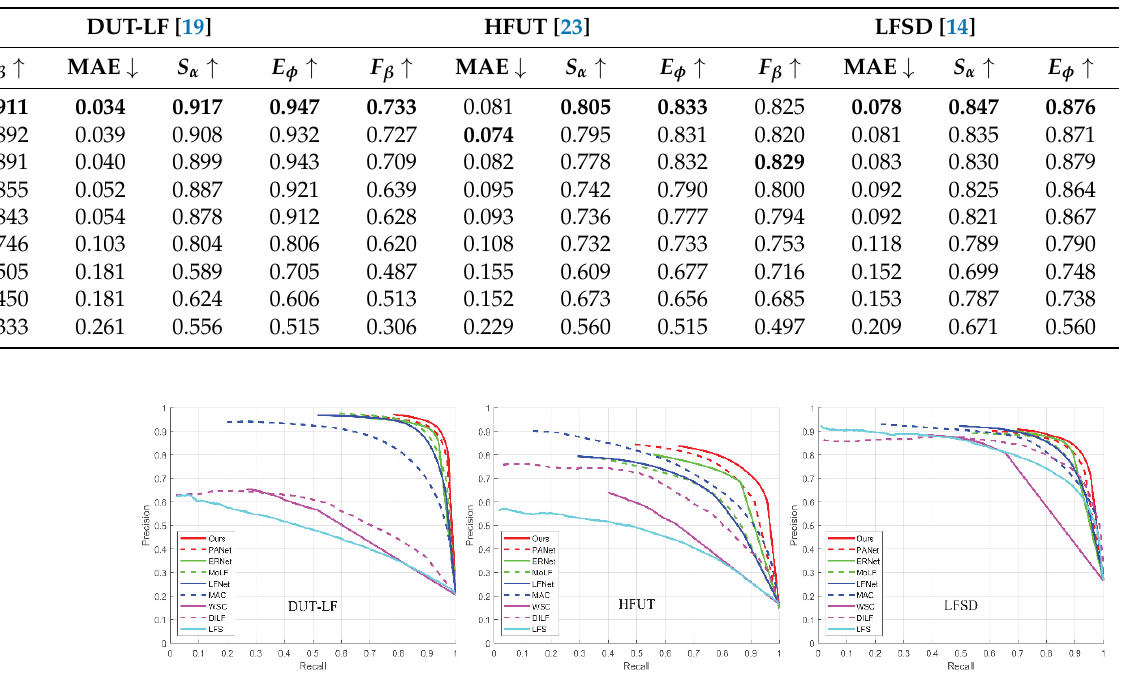
Figure 4. Precision-recall curves of our proposed method and other state-of-the-art light methods on three popular datasets.